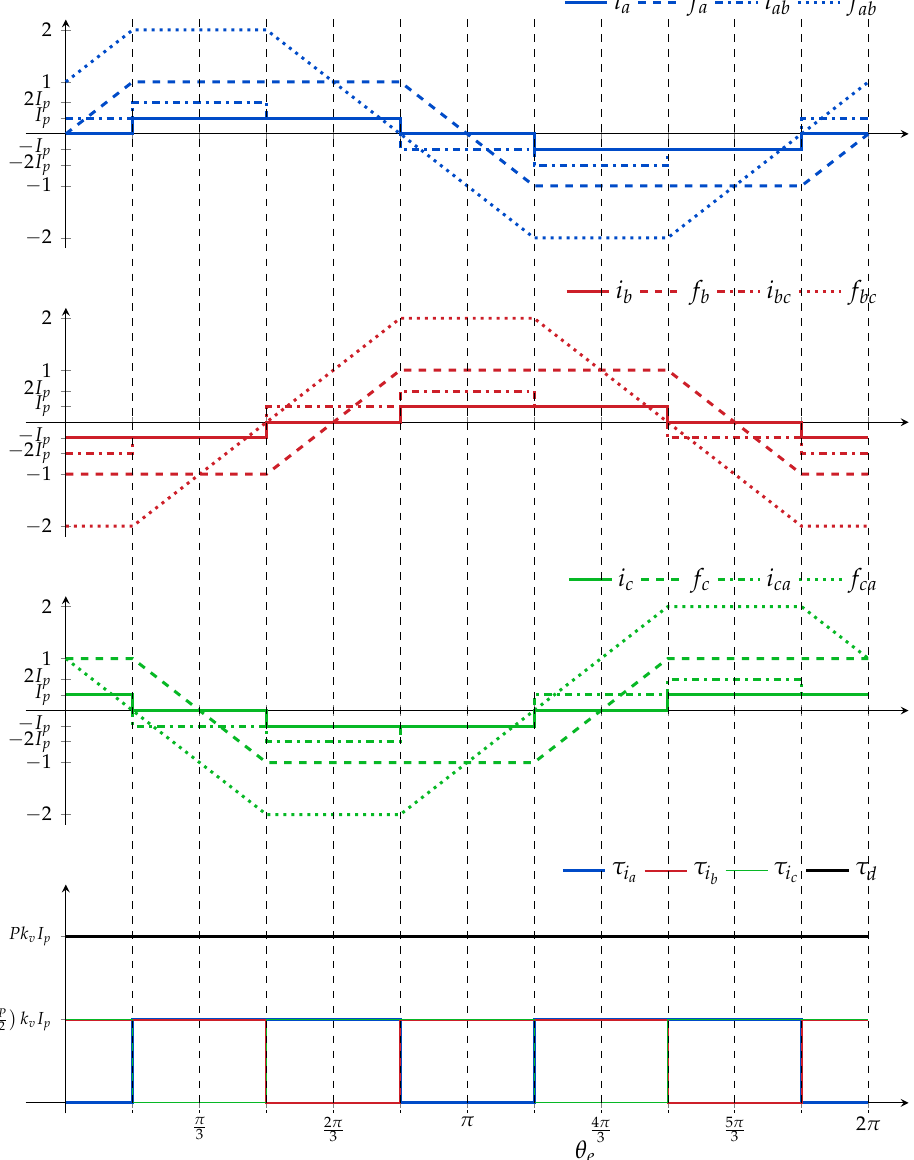
Figure 1. Ideal developed torque. The top three plots show the ideal phase current ( continuous line ) and back-emf ( dashed line ) waveforms. The bottom plot shows the resultant torque produced by each winding and the developed torque T e